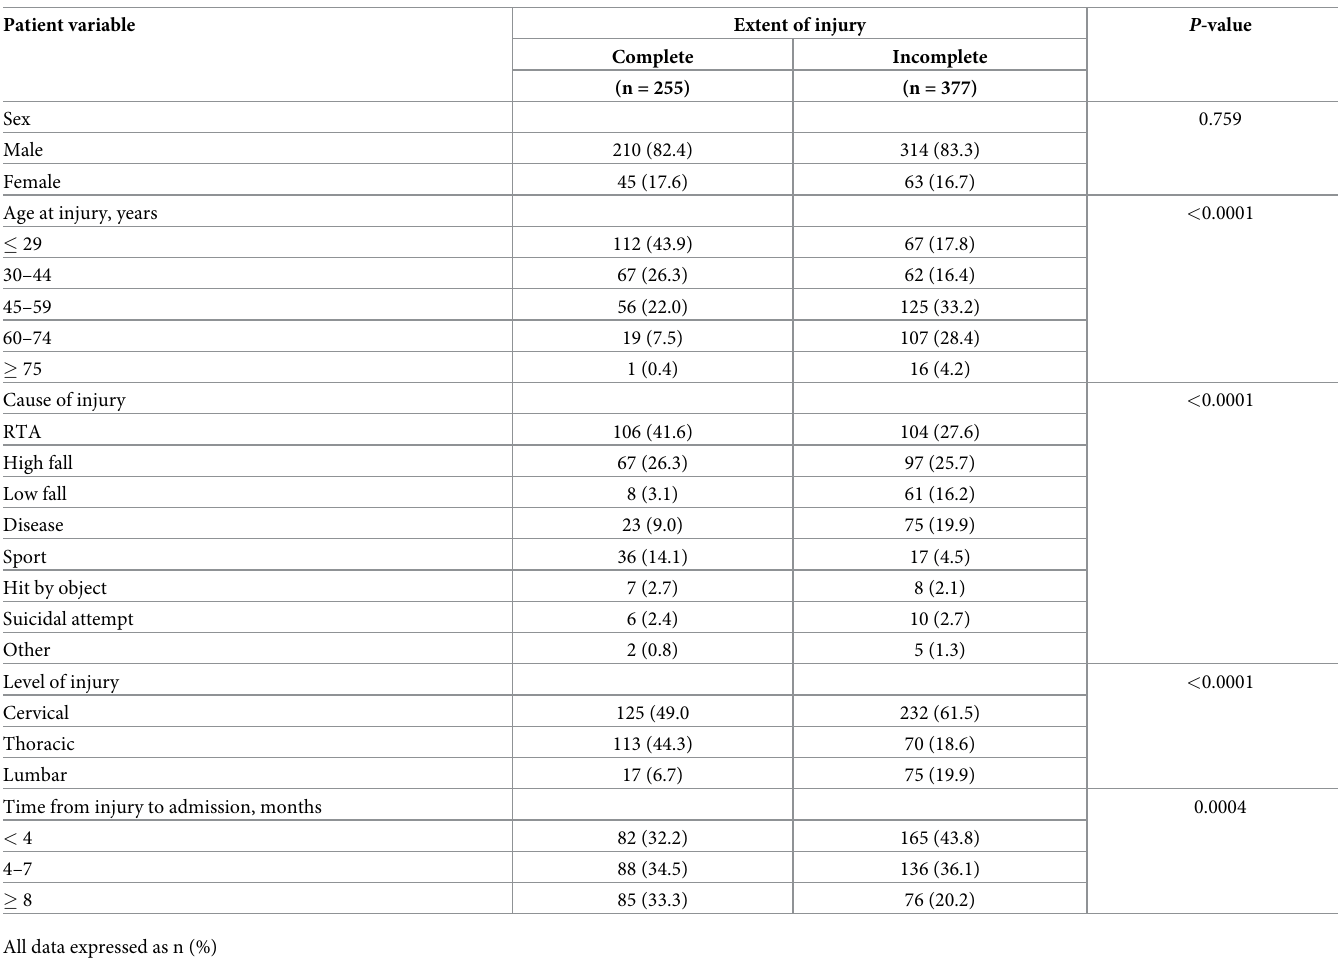
Table 1. Patient comparison by extent of spinal cord